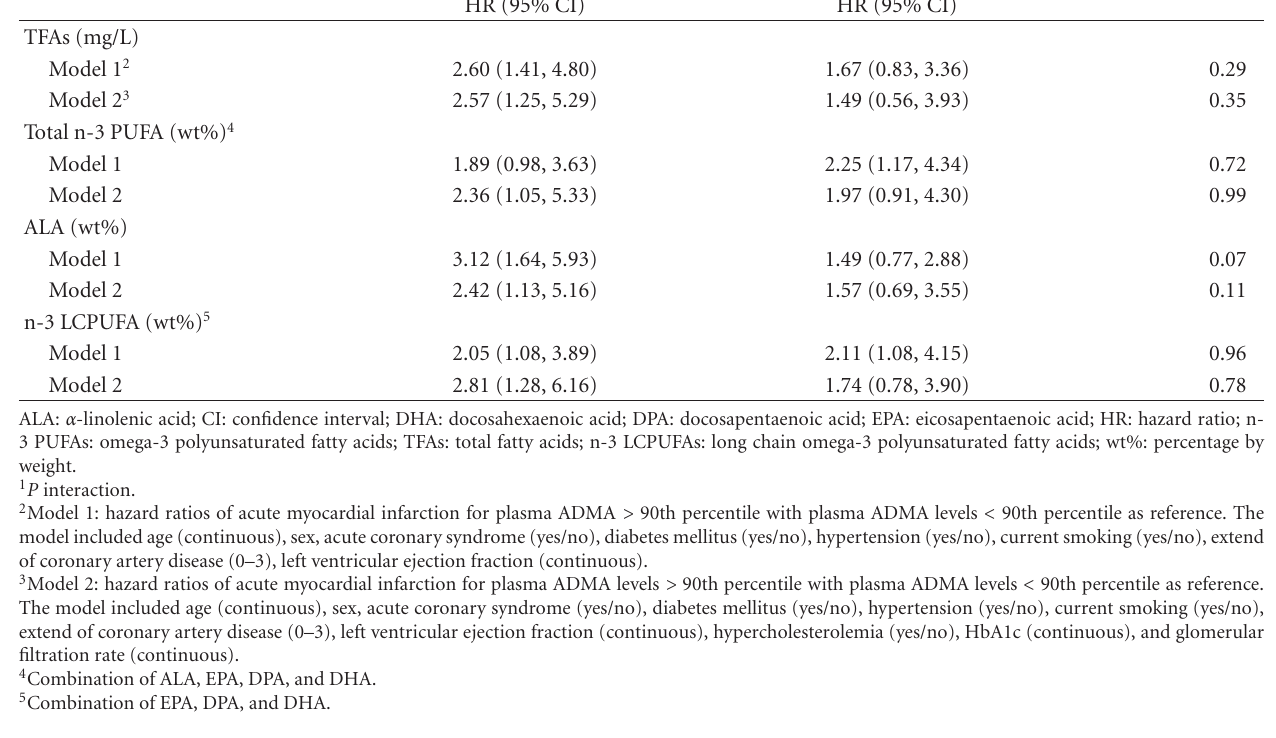
Table 4: Risk of acute myocardial infarction for the upper decile of ADMA in strata of TFAs and n-3 PUFA. Fatty